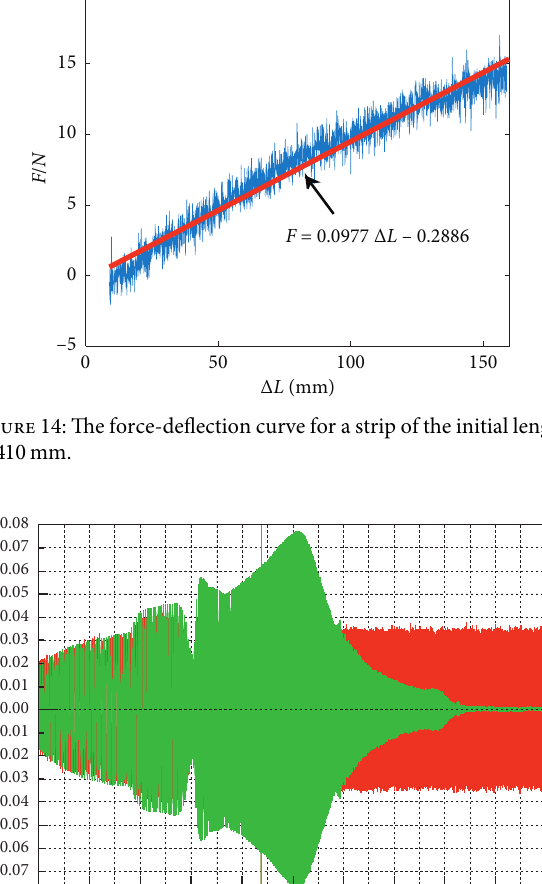
Figure 12: The picture of the experimental apparatus.